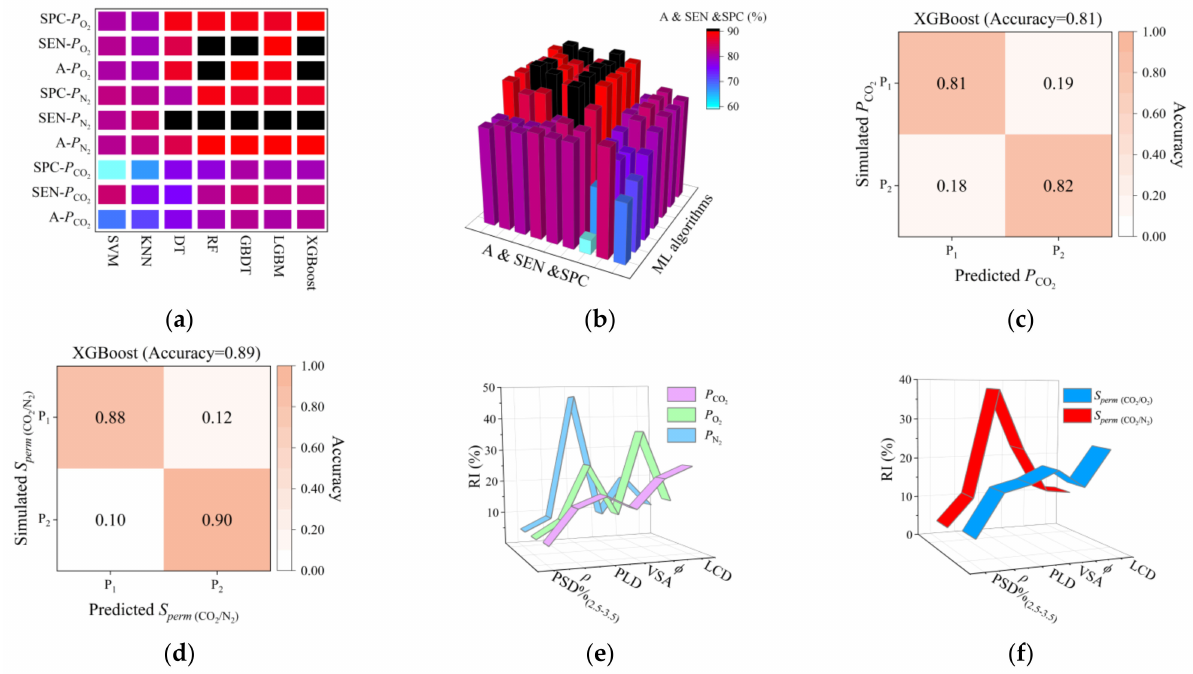
Figure 4. ( a , b ) Prediction accuracy comparison of seven classification algorithms; ( c ) confusion matrix for P CO ; ( d ) confusion matrix for S perm (CO ; ( e ) RI comparison of P CO 2 2 /N 2 ) comparison of S pe rm (CO and S perm (CO 2 /N 2 ) 2 /O 2 )